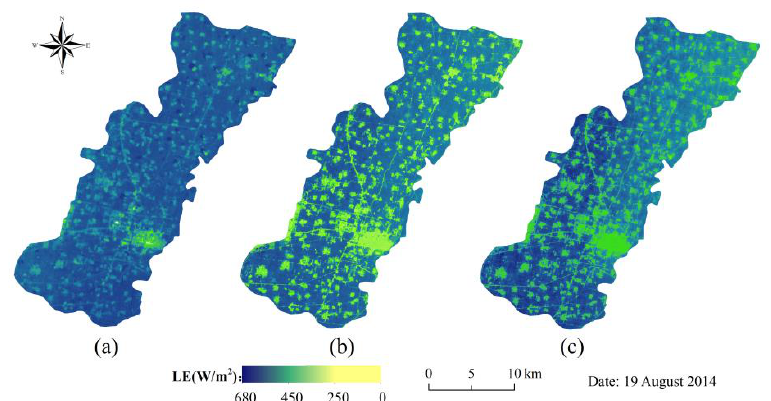
Figure 6. Spatial distribution of instantaneous summer maize LE derived from Landsat 8 on 19 August of 2014 for the ( a ) TSEB, ( b ) 4s-PM, and ( c ) PT-JPL models.